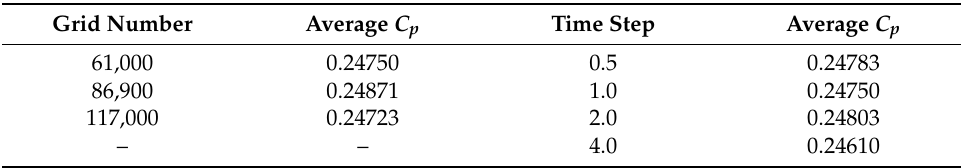
Table 3. Average C p for different densities and time steps.